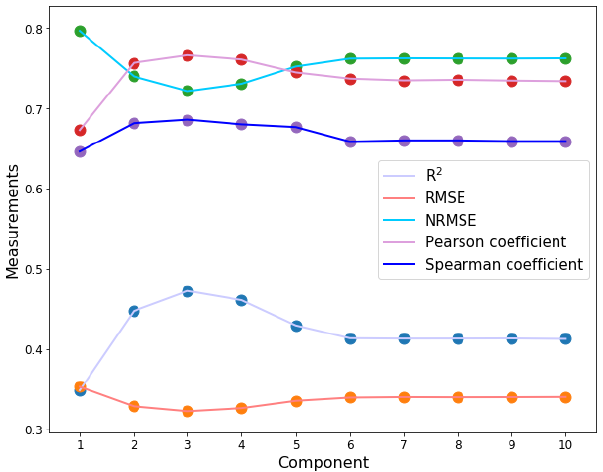
Figure 1. Curves of five performance measures produced by PLSR with component number rang- ing from 1 to 10 and 647 features trained by using the PLSR model as the input space. When the component number is 3, RMSE and NRMSE achieve the lowest value; R 2 , Pearson’s correlation coefficient, and Spearman’s coefficient have the highest value. Therefore, the PLSR shows the best performance when the number of principal components is 3. R 2 is the coefficient of determina- tion, and RMSE , NRMSE is the root mean square error and the normalized root-mean-square error,